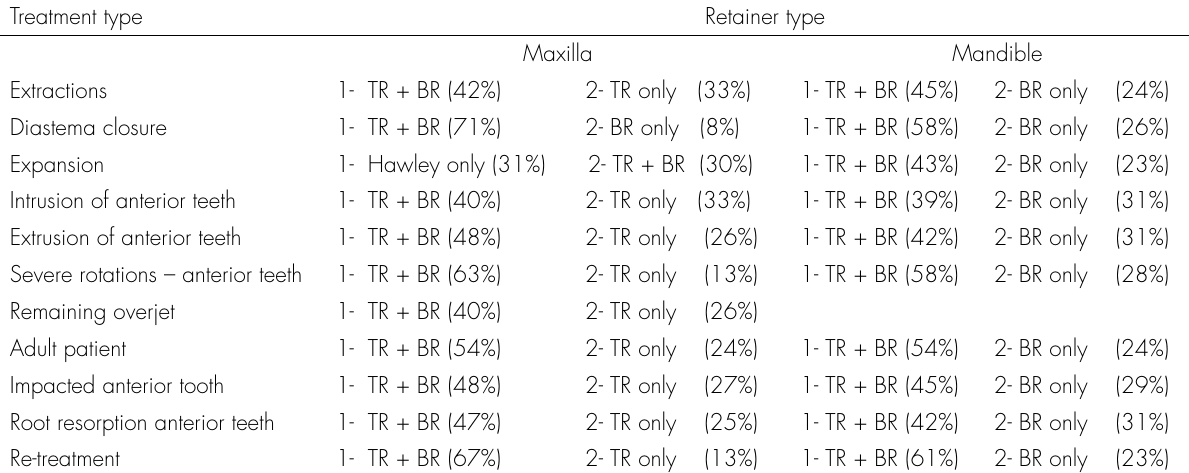
Table X. Retainer choice after specific treatment types by